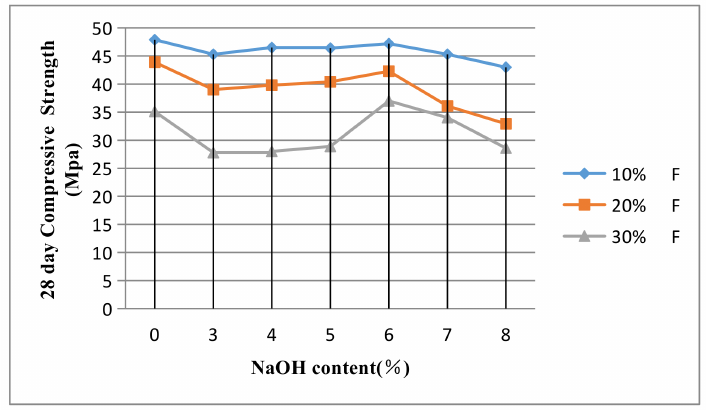
Figure 3. NaOH content–compressive strength curves at 28